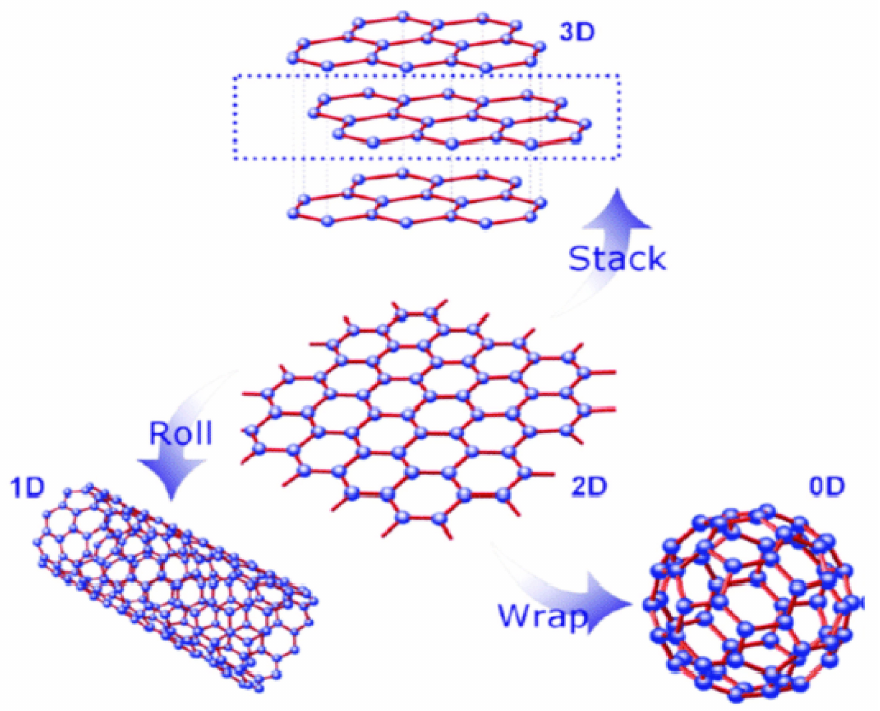
Figure 1. Structural representation of 2D graphene with different dimensions. [Reprinted with